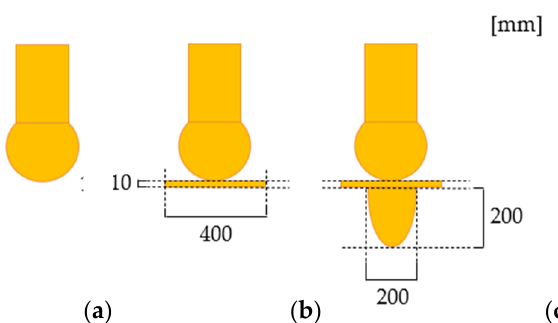
Figure 3. Three types of footing design ( a ) Sphere, ( b ) Plate, and ( c ) Semi ‐ Spheroid models.